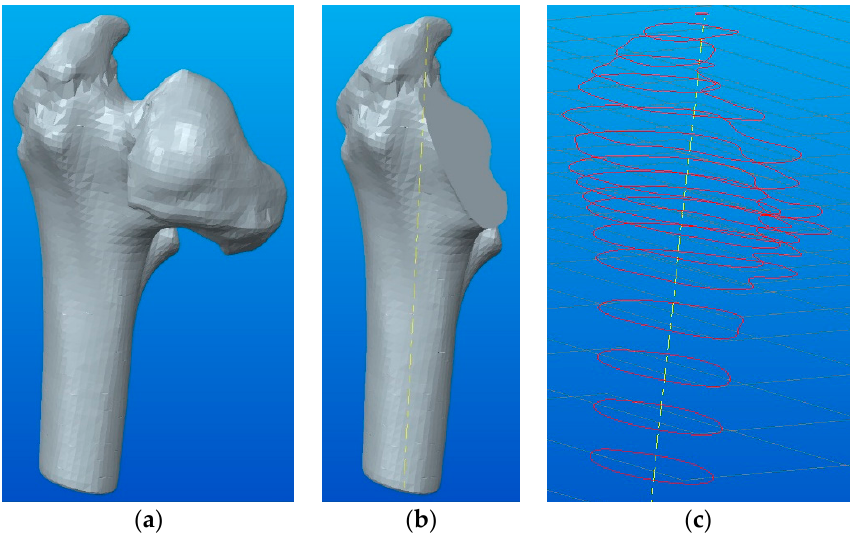
Figure 6. Steps for converting the STL files into 3D solid models using geometric modeling in Creo Parametric: ( a ) 3D solid model obtained using the Shrinkwrap function; ( b ) tracing the femur axis (shaft); ( c ) achievement of the drawings in different sections.